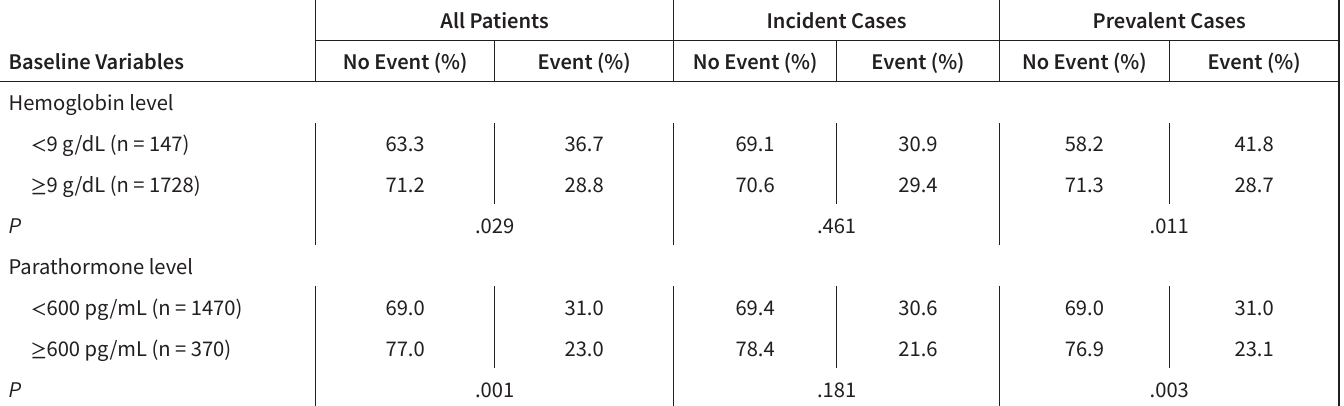
Table 5. The Rate of Primary Outcome in Incident and Prevalent Patients by Hemoglobin and Parathormone Status All Patients Incident Baseline Variables